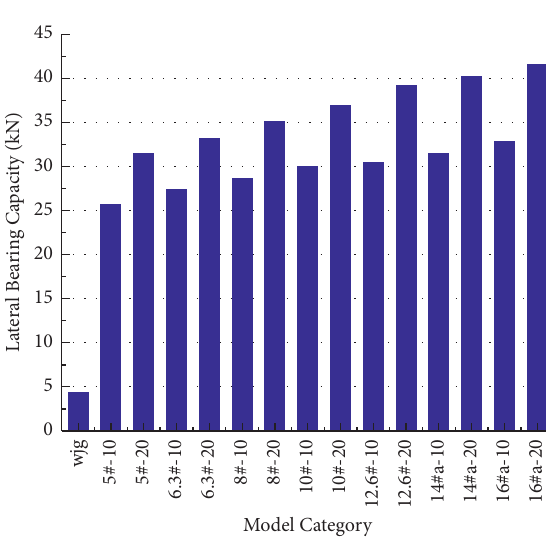
Figure 19: Ultimate bearing capacity of group B models.